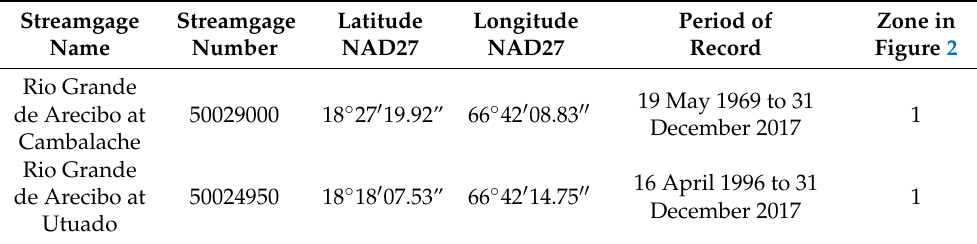
Table 3. Streamgaging stations on the R í o Grande de Arecibo with discharge data suitable for model calibration and comparison [21]; NAD27, North American Datum of